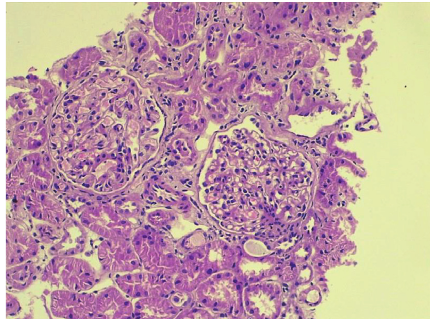
Figure 1: Kidney biopsy specimen on light microscopy showing a normal-appearing glomerulus without any proliferation or capil- lary wall thickening.